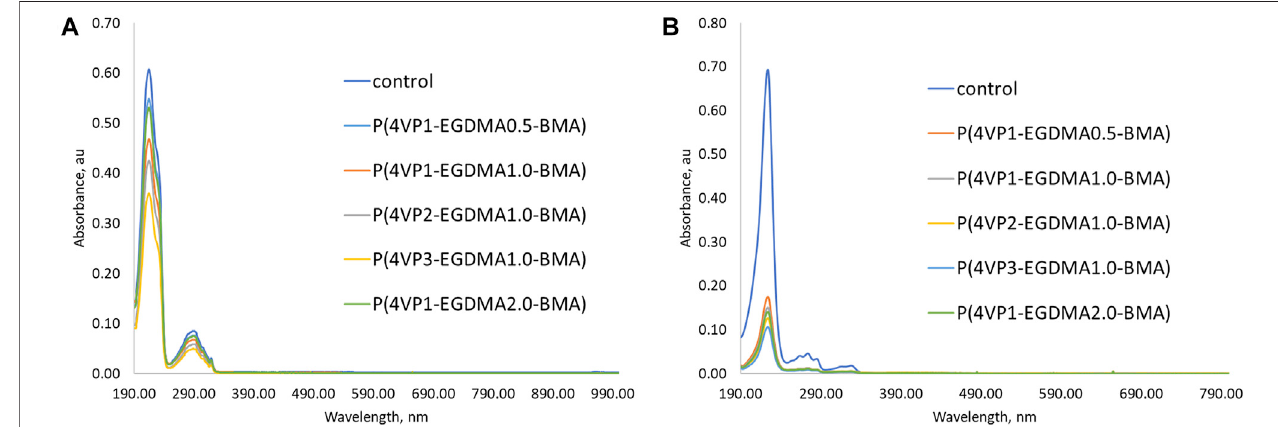
FIGURE9| UV-Visspectraforthe fi vecrosslinkedpolymerbeadsfollowingovernight(17 h)bindingexperimentinaqueoussolutionsof (A)PPL-HCl and (B)2NO .